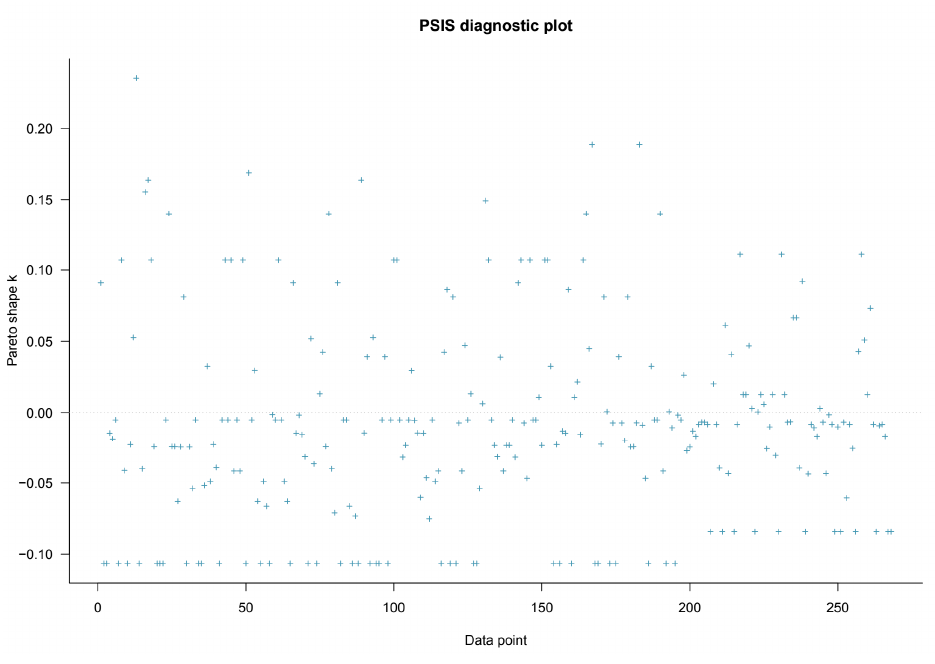
Figure 2. The model’s PSIS diagnostic plot. Table 2. The model’s simulated